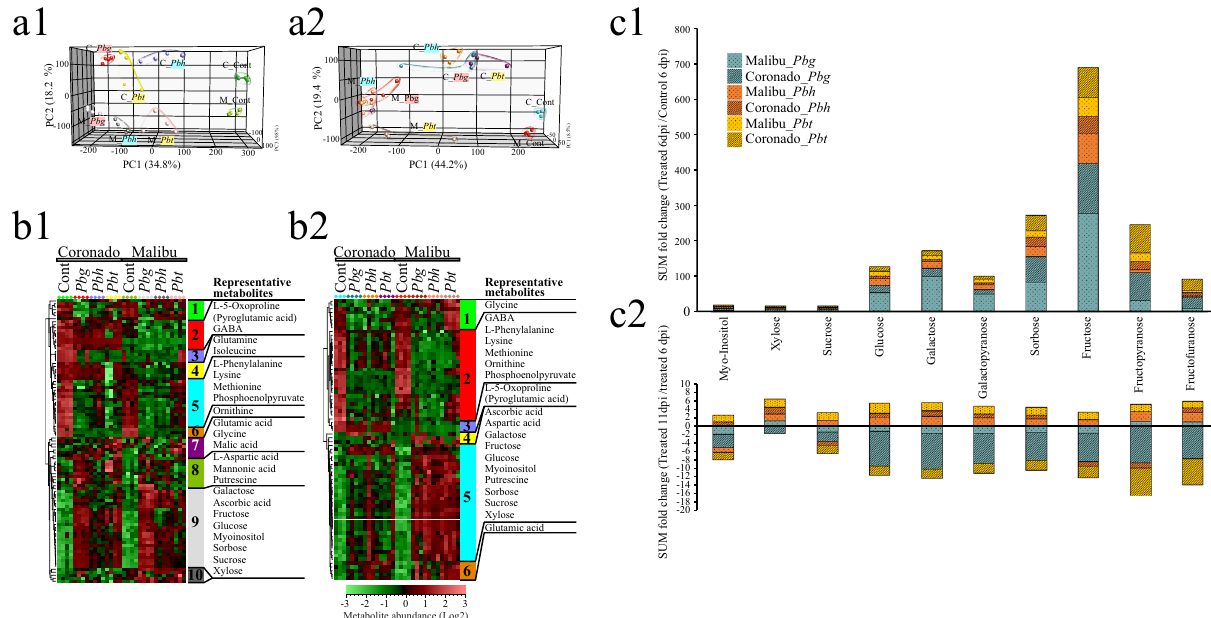
Figure 3. Paraburkholderia -mediated changes in shoot primary metabolites in two Broccoli cultivars. ( a ) Principal Component Analysis (PCA) and ( b ) Hierarchical Cluster Analysis (HCA) based on differentially regulated metabolites of the samples at 6 dpi ( 1 ) and 11 dpi ( 2 ). In the HCA, metabolite clusters are indicated by different colors. Information on the representative metabolites of each clusters is given on the right side, if the metabolites are annotated. ( c ) Impact of Paraburkholderia species on sugar generation ( 1 ) and utilization ( 2 ) of two Broccoli cultivars. Broccoli cultivars (Cor: Coronado, Mal: Malibu), Cont.: non-rhizobacteria treated control, Pbg : Paraburkholderia graminis PHS1, Pbh : P. hospita mHSR1, and Pbt : P. terricola